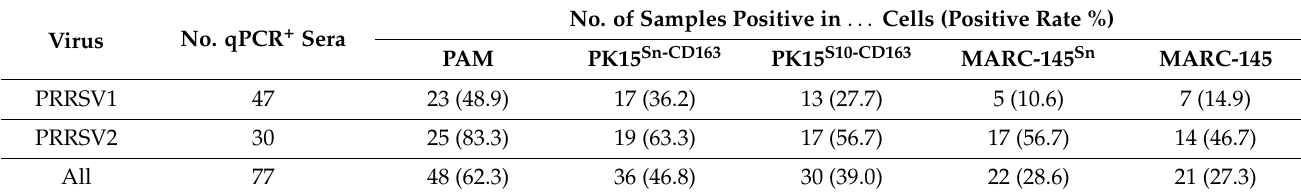
Table 1. Summary of virus isolation rate in PAM, PK15 Sn-CD163 , PK15 S10-CD163 , MARC-145, and MARC-145 Sn . Virus No. qPCR + Sera